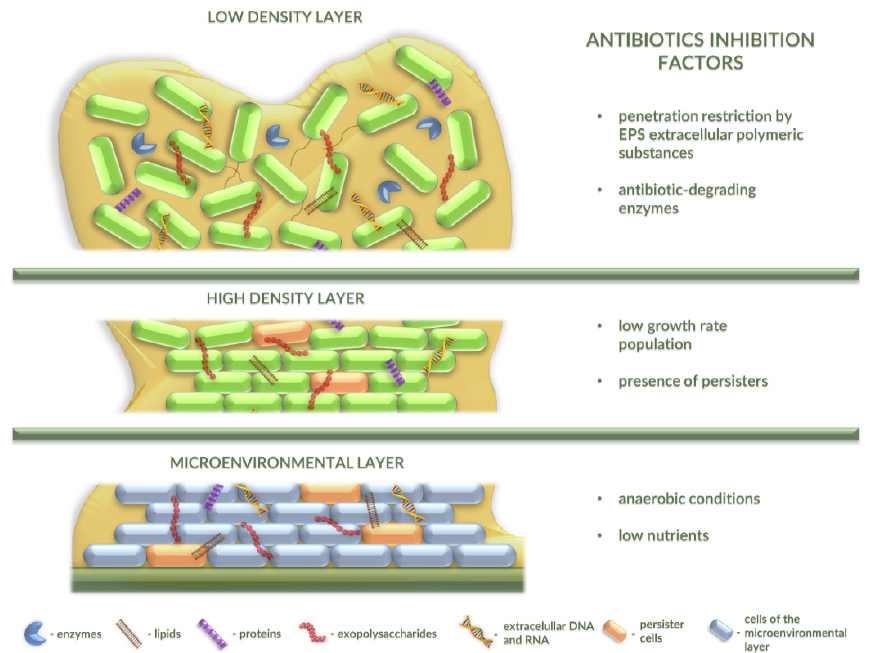
Figure 2. Bacterial biofilm layers and factors that can inhibit activities of antibiotics. Mature biofilm may be divided into three layers: low-density layer, high-density layer, and microenvironmental layer with slow growth and persister cells. All of the layers contain anti-antibiotic factors and can resist antibiotic activity in different ways.